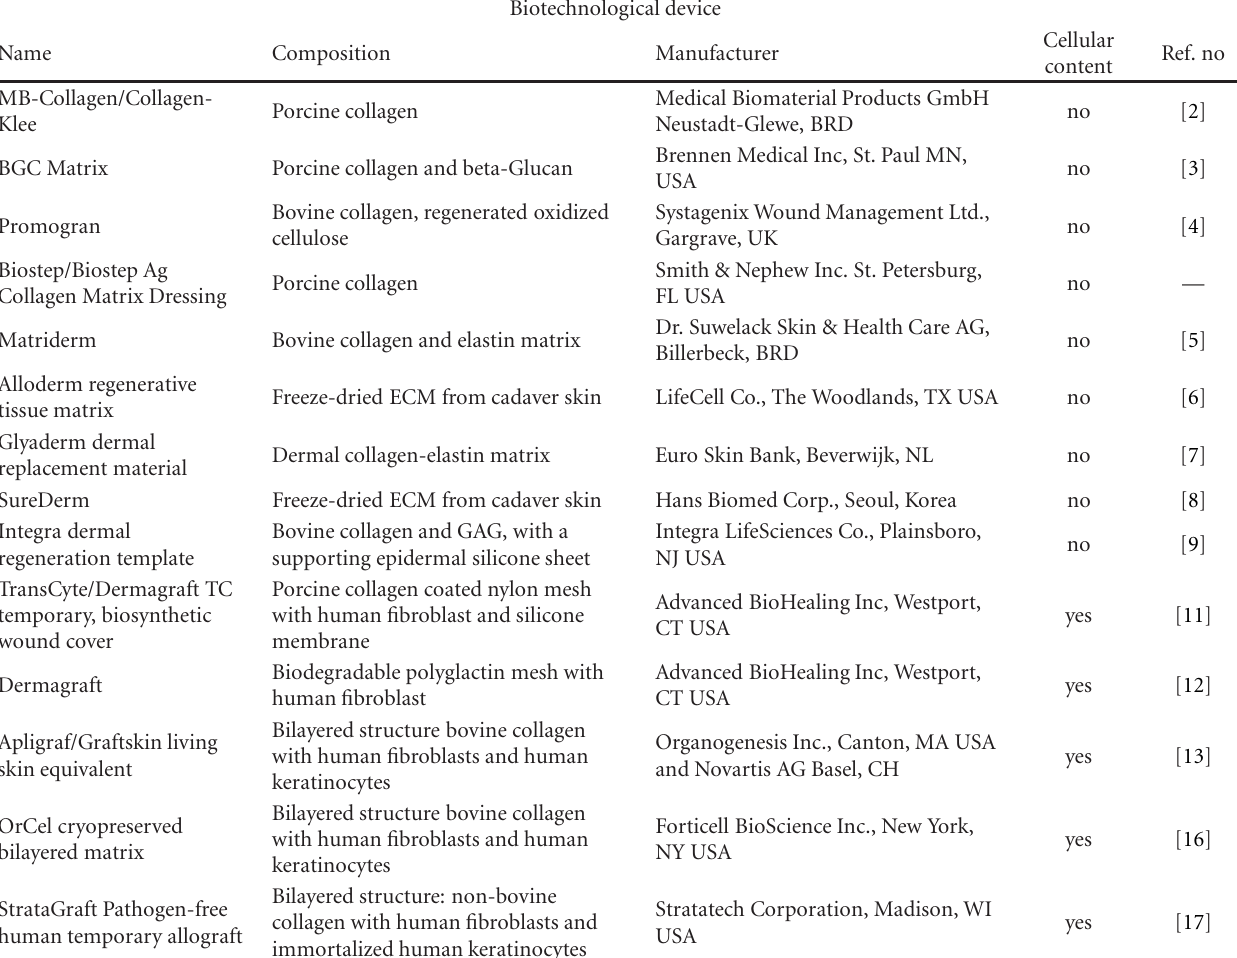
Table 1: Biotechnologically derived products designed to improve dermal wound